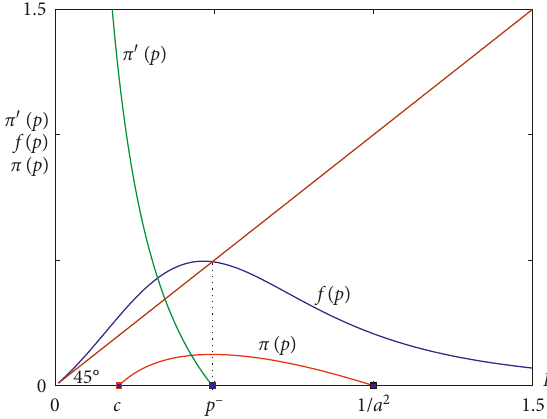
Figure 2: The shapes of the functions π with a line with 45 ° . It is clear that π while max π